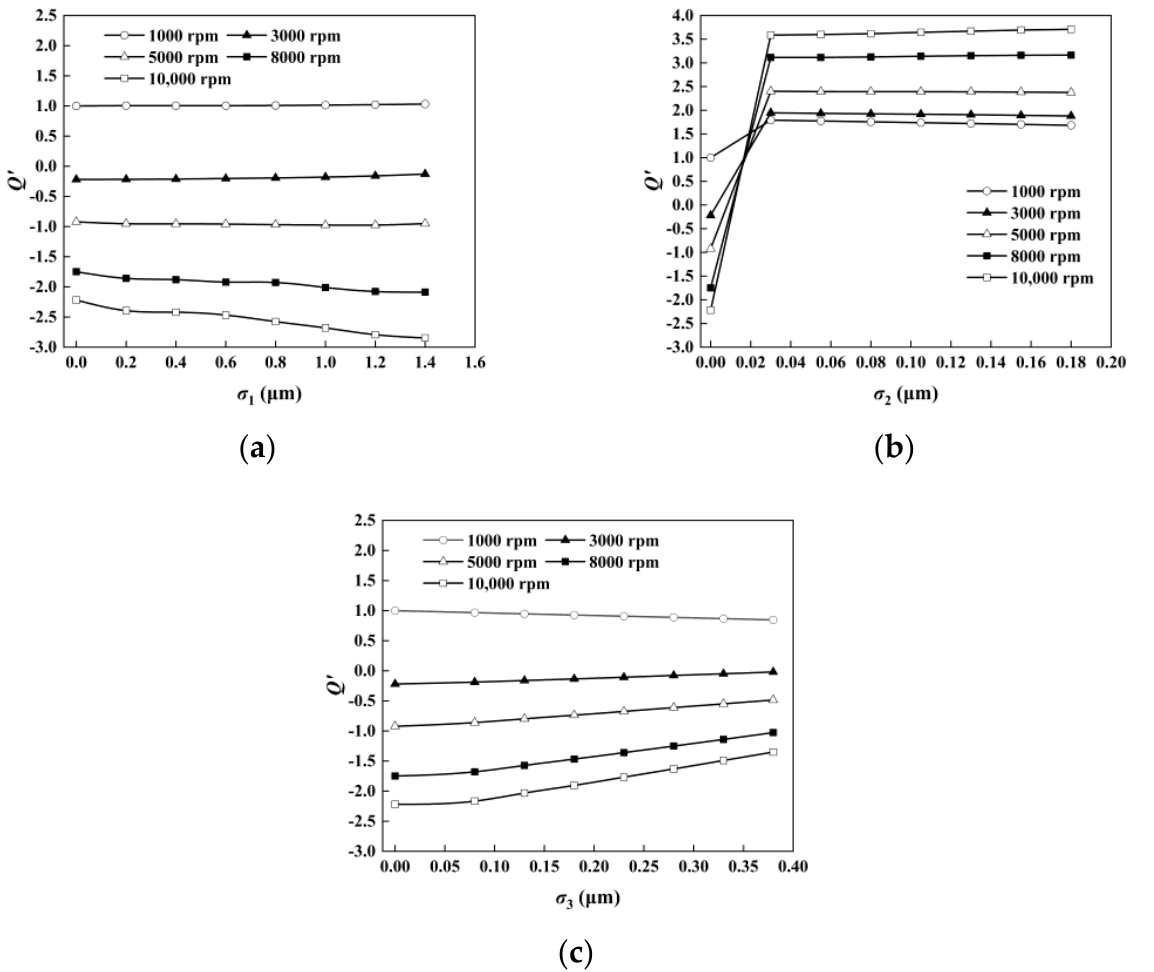
Figure 17. Effect of the roughness of different parts of the leakage: ( a ) the grooved zone of the rotating ring was rough, ( b ) the non-grooved zoned of the rotating ring was rough, ( c ) the stationary ring surface was